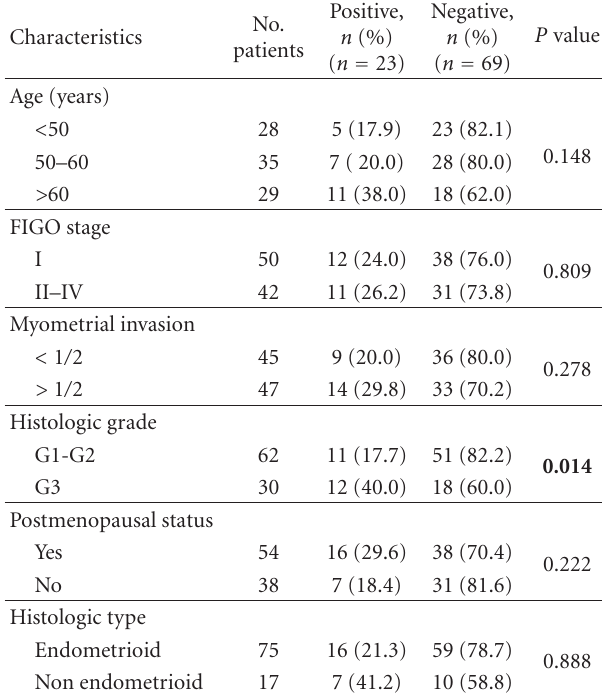
Table 7: Associations between P16INK4a expression and clinico- pathologic parameter for endometrial